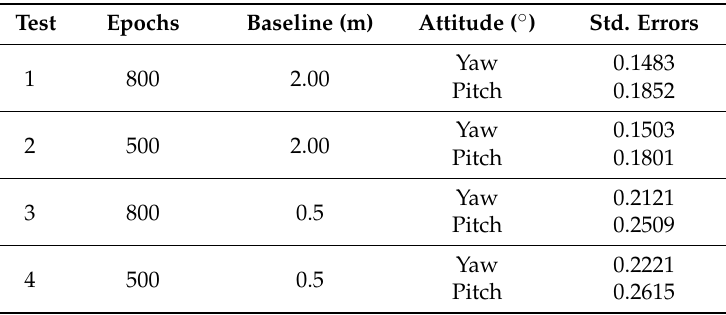
Table 2. Standard errors of attitude determination experiment.